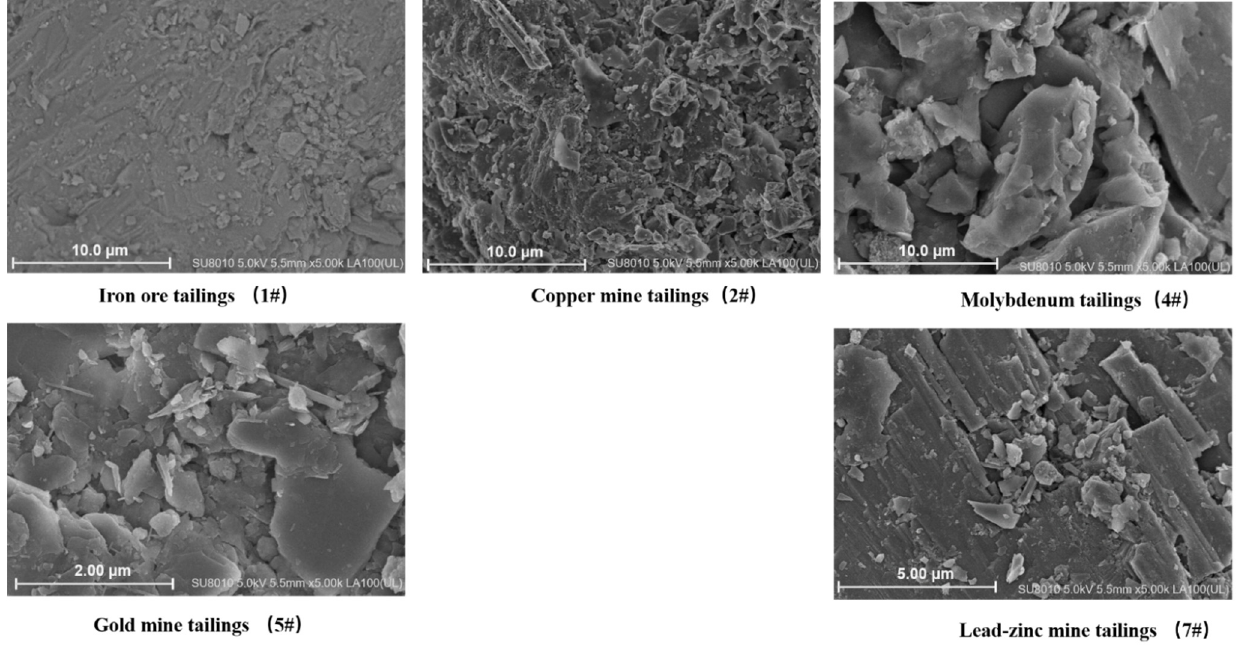
ratio of tailings is different. These results were different from reports by Pan [2], Gao [16], Rösner [17], Zhao [18] and Chen [19].